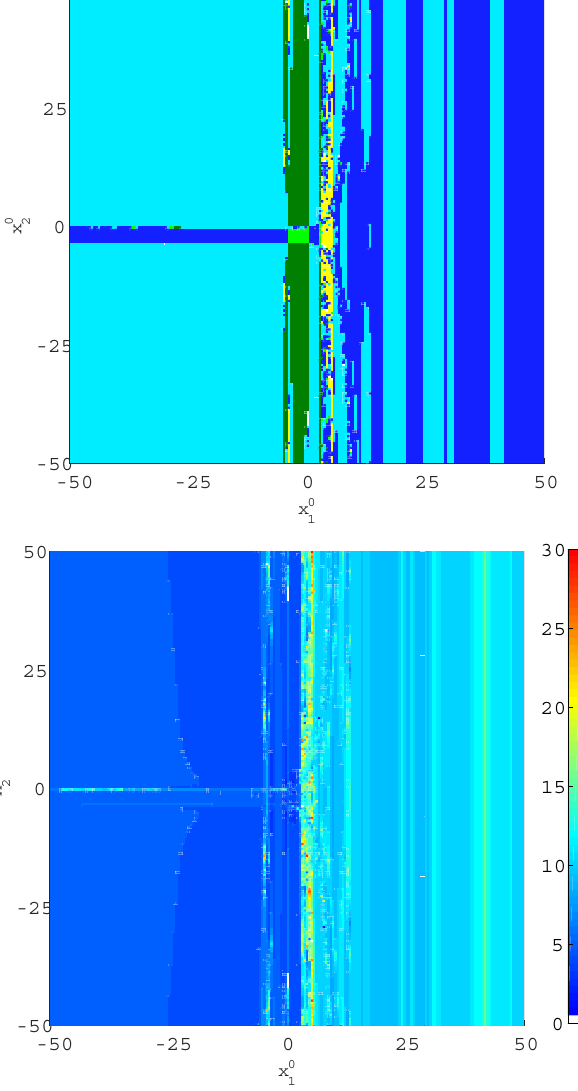
Figure 7. Basins of attraction ( upper ) and number of iterations ( lower ) for Kelley’s system when the factored method with m = 2 is